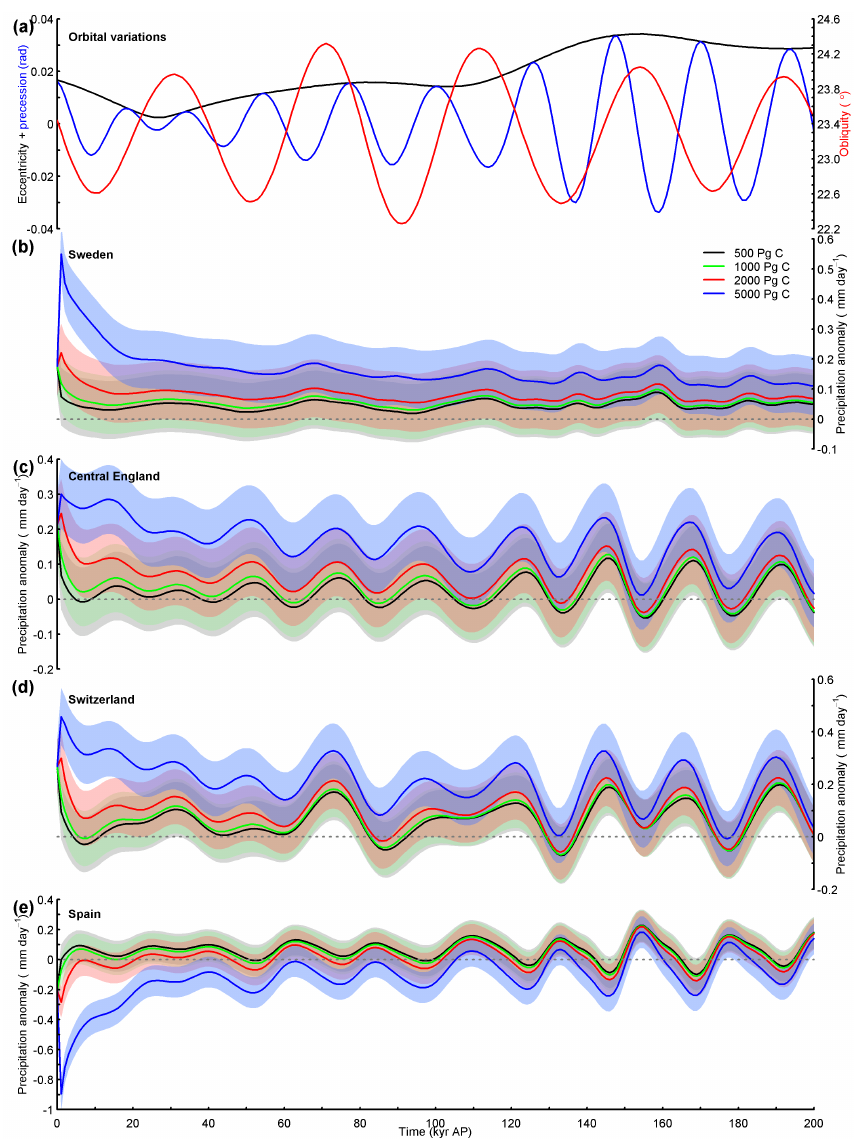
Figure 15. Emulation of precipitation anomaly for the next 200kyr. (a) Time series of orbital variations (Laskar et al., 2004), showing eccentricity (black) and precession (radians, blue) on the left axis and obliquity ( ◦ , red) on the right axis. (b) – (e) Time series of emulated grid box mean annual precipitation (mmday − 1 ), modelled every 1kyr, for four CO 2 emissions scenarios: 500PgC (black), 1000PgC (green), 2000PgC (red) and 5000PgC (blue). Modelled using the modice emulator. Error bands represent the emulated grid box posterior variance (1SD). Four sites are presented, representing grid boxes in Sweden, central England, Switzerland and Spain. Precipitation is shown as an anomaly compared with the pre-industrial control simulation. Note the different vertical axis